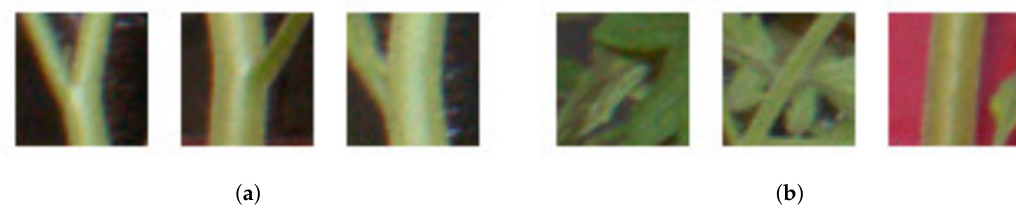
Figure 3. Examples of patches used for the training based on BoVWs. ( a ) node regions; ( b ) non-node